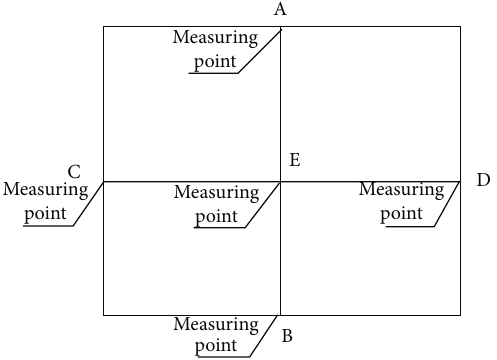
Figure 17: Schematic map of measuring point